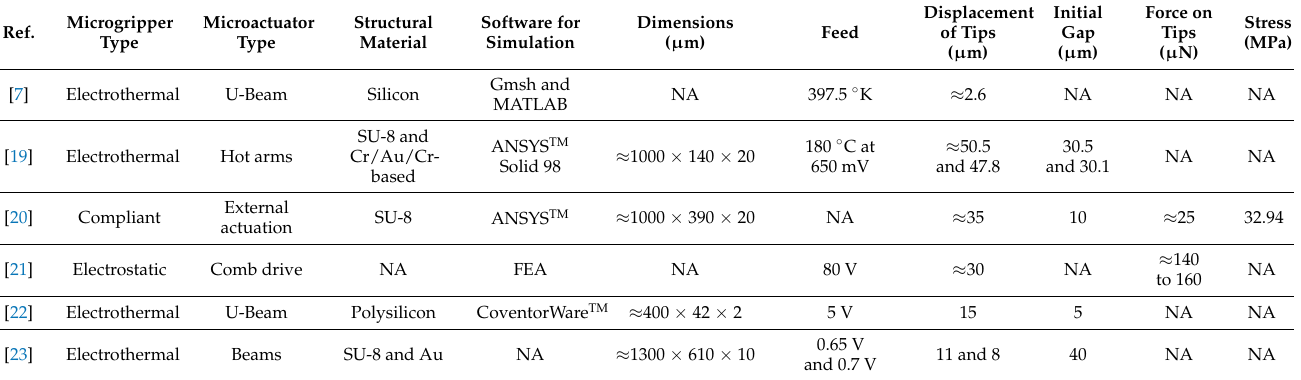
Table 1. State-of-the-art of recent microgrippers, their actuators, and fundamental parameters.